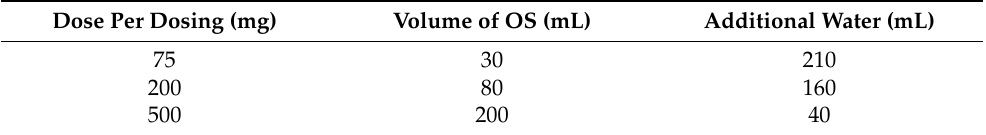
Table 2. Dosing conditions applied for FIH clinical trials. Dose Per Dosing (mg) Volume of OS (mL) Additional Water